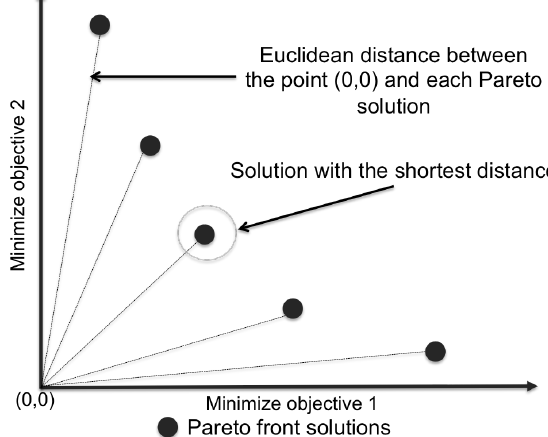
Figure 4. Points in the Pareto front represent the trade-off between both objectives. The Euclidean distance was computed between each Pareto solution and the reference point (0,0). The solution with the shortest distance was considered as the chosen one to be compared with the GABN